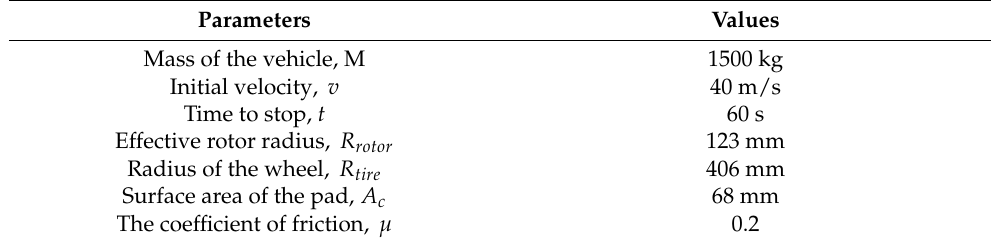
Table 1. Vehicle data and initial state.